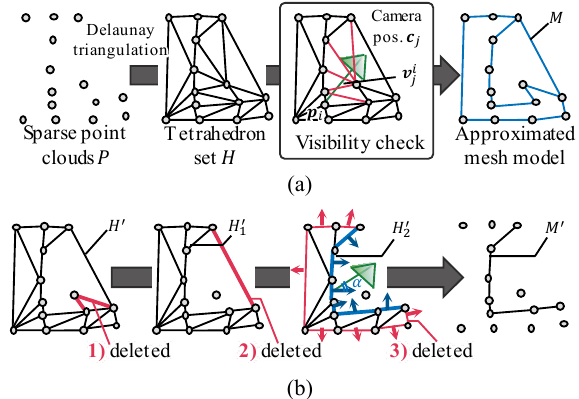
Figure 2. Approximated triangular mesh generation processes. (a) Our previous method (Moritani, 2019). (b) Proposed mesh